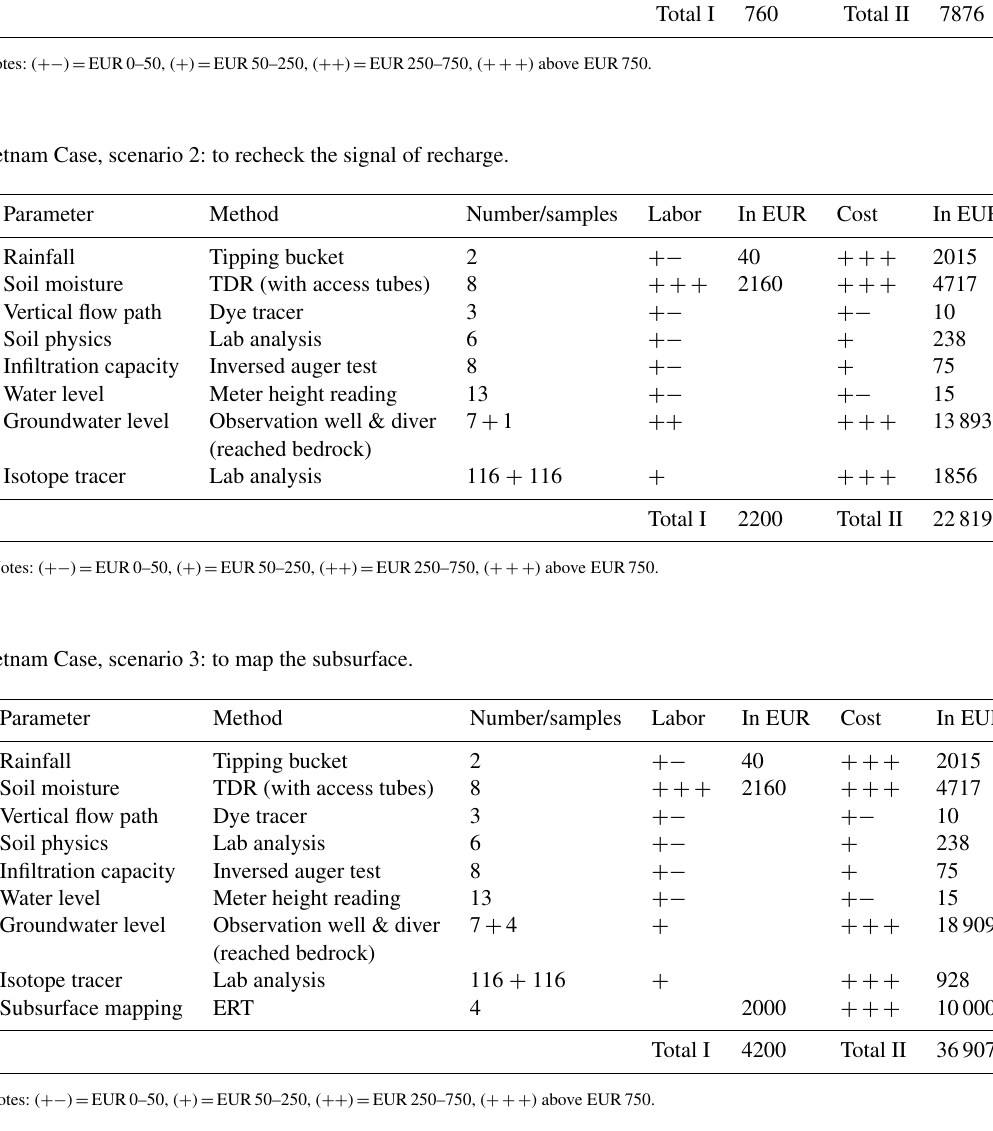
Table A1. Vietnam Case, scenario 1: to measure rainfall and groundwater level for a short period. Parameter Method Number/samples Labor Cost In EUR Rainfall Tipping bucket Soil physics Infiltration capacity